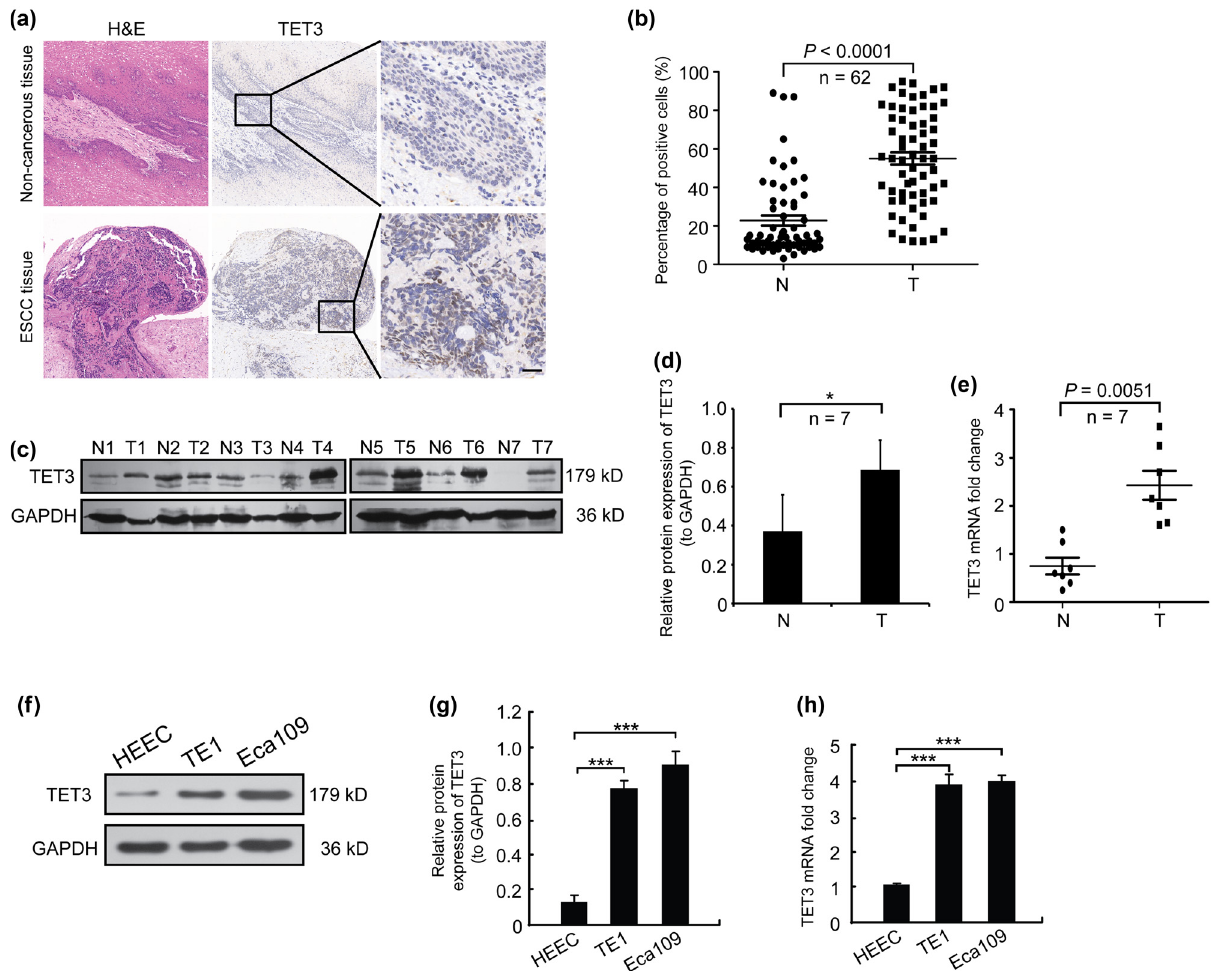
Figure 1: TET3 is up - regulated in ESCC. ( a ) Representative fi elds of TET3 protein level in ESCC tissue samples ( scale bar = 50 μ m ) . ( b ) Statistical analysis of the proportion of positive cells in immunohistochemical results of ESCC tissue sections. ( c ) Protein levels of TET3 in paired ESCC tissues ( n = 7 ) . ( d ) Statistical analysis of the protein levels of TET3 in paired ESCC samples ( n = 7 ) . ( e ) RT - qPCR assays were used to measure TET3 mRNA in ESCC tissues. ( f ) Protein levels of TET3 in ESCC cell lines. ( g ) Statistical analysis of the protein expression levels of TET3 in ESCC cell lines. ( h ) RT - qPCR assays were used to detect TET3 mRNA in ESCC tissues. * P < 0.05, *** P < 0.001. N, non - tumor tissue; T, tumor